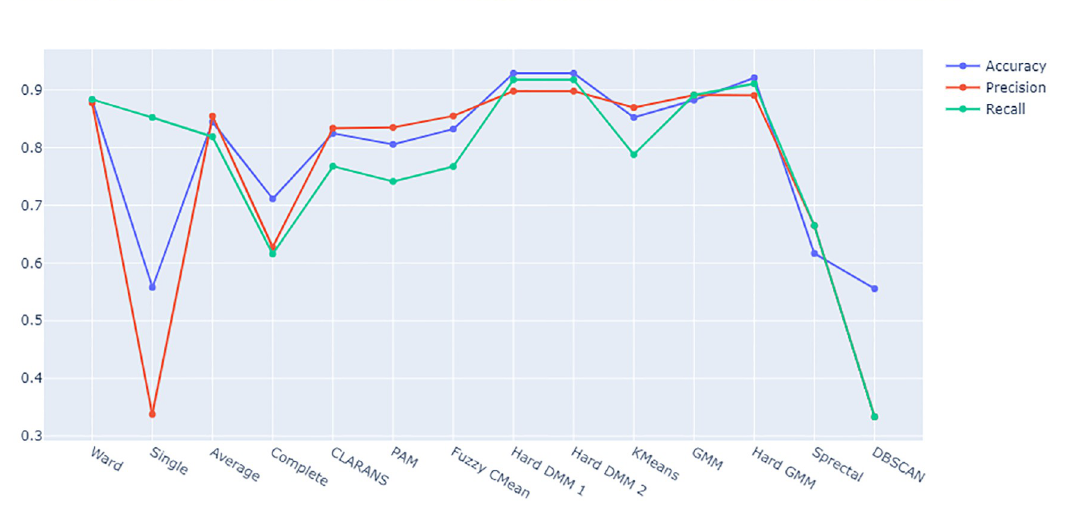
Fig 5. Plot of accuracy, precision and recall of different clustering algorithms on data generated under scheme 1.